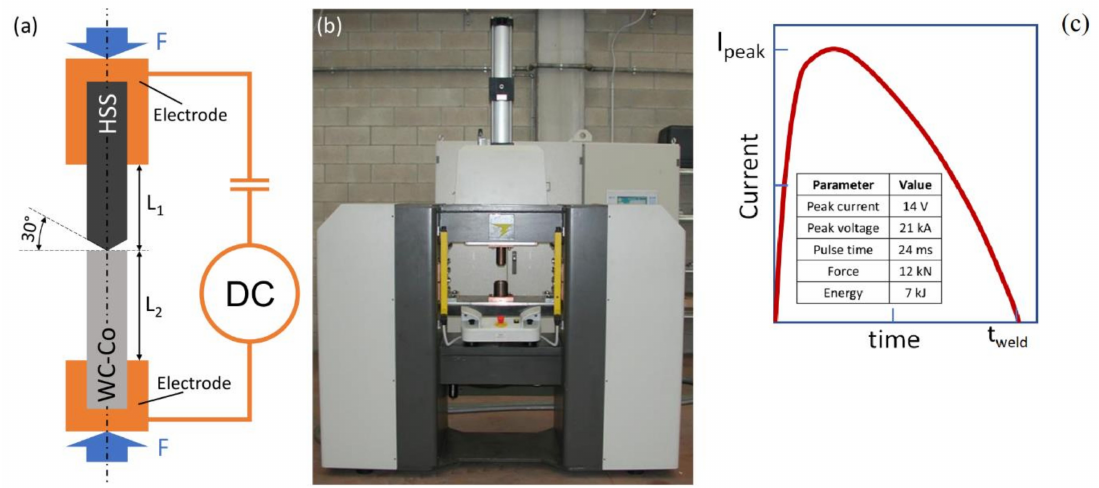
Figure 1. ( a ) Sketch (out of scale) of the capacitor discharge welding (CDW) tool-sample system arrangement, F is the pre-load set in the calibration stage, ( b ) CDW machine and ( c ) current waveform adapted from the low-resolution machine display